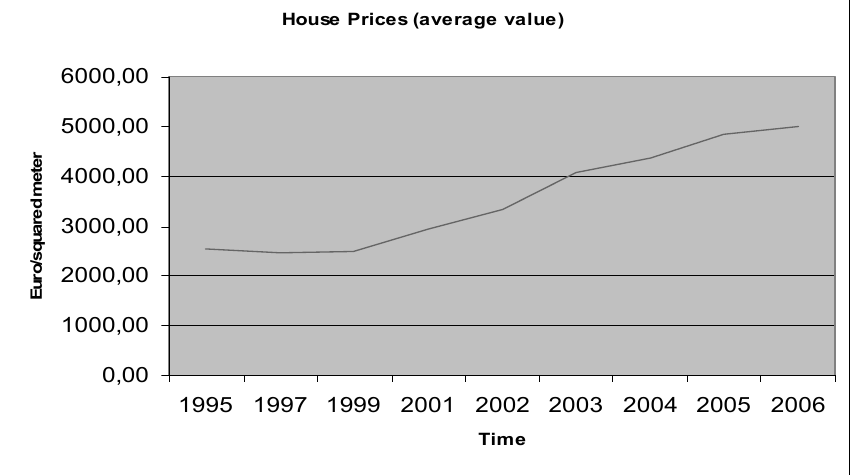
House Prices (average value)